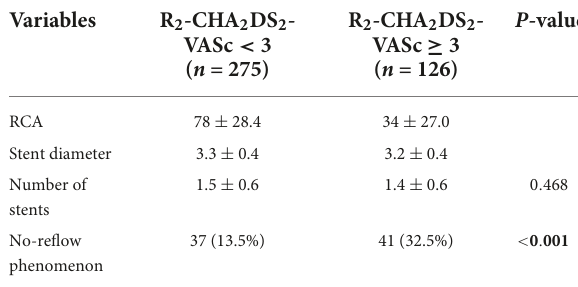
TABLE 1 Baseline clinical